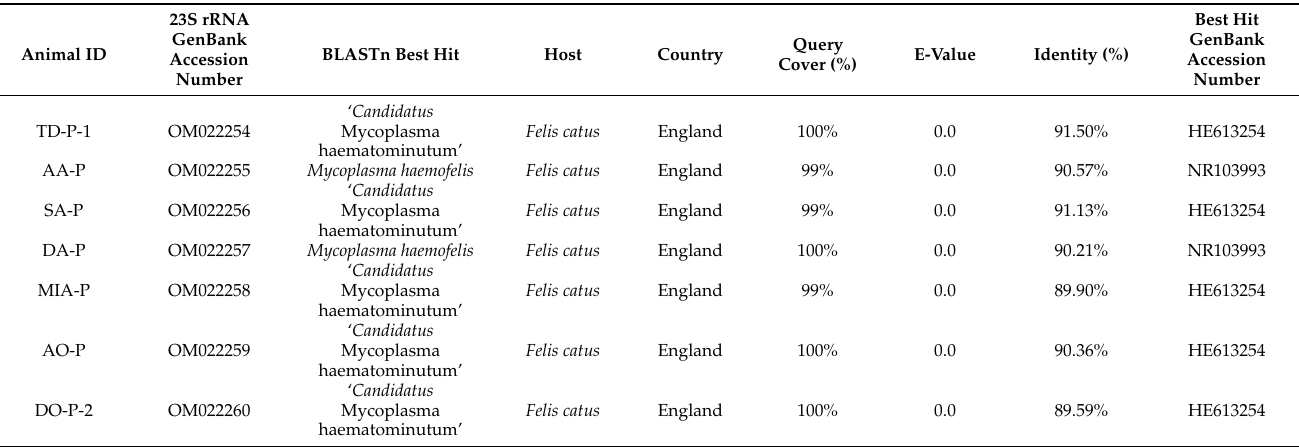
Table 3. BLASTn analysis of each partial hemoplasma 23S rRNA sequence obtained from free-ranging tapirs from the Brazilian biomes of Cerrado and